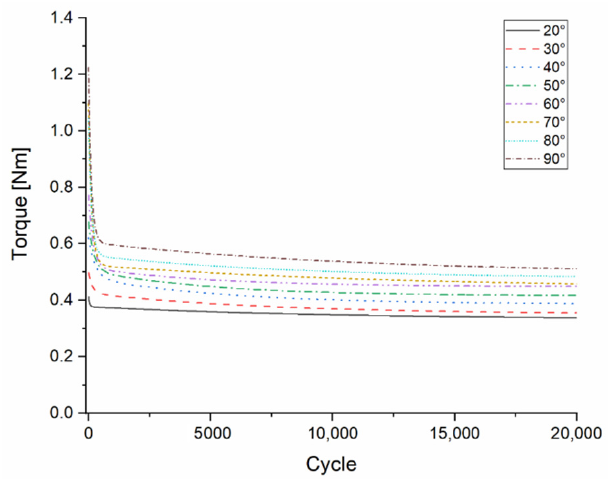
Figure 8. Results of torsion fatigue testing of the composite material. The colored curves show the decrease in Torque (Nm) measured at different rotation values.